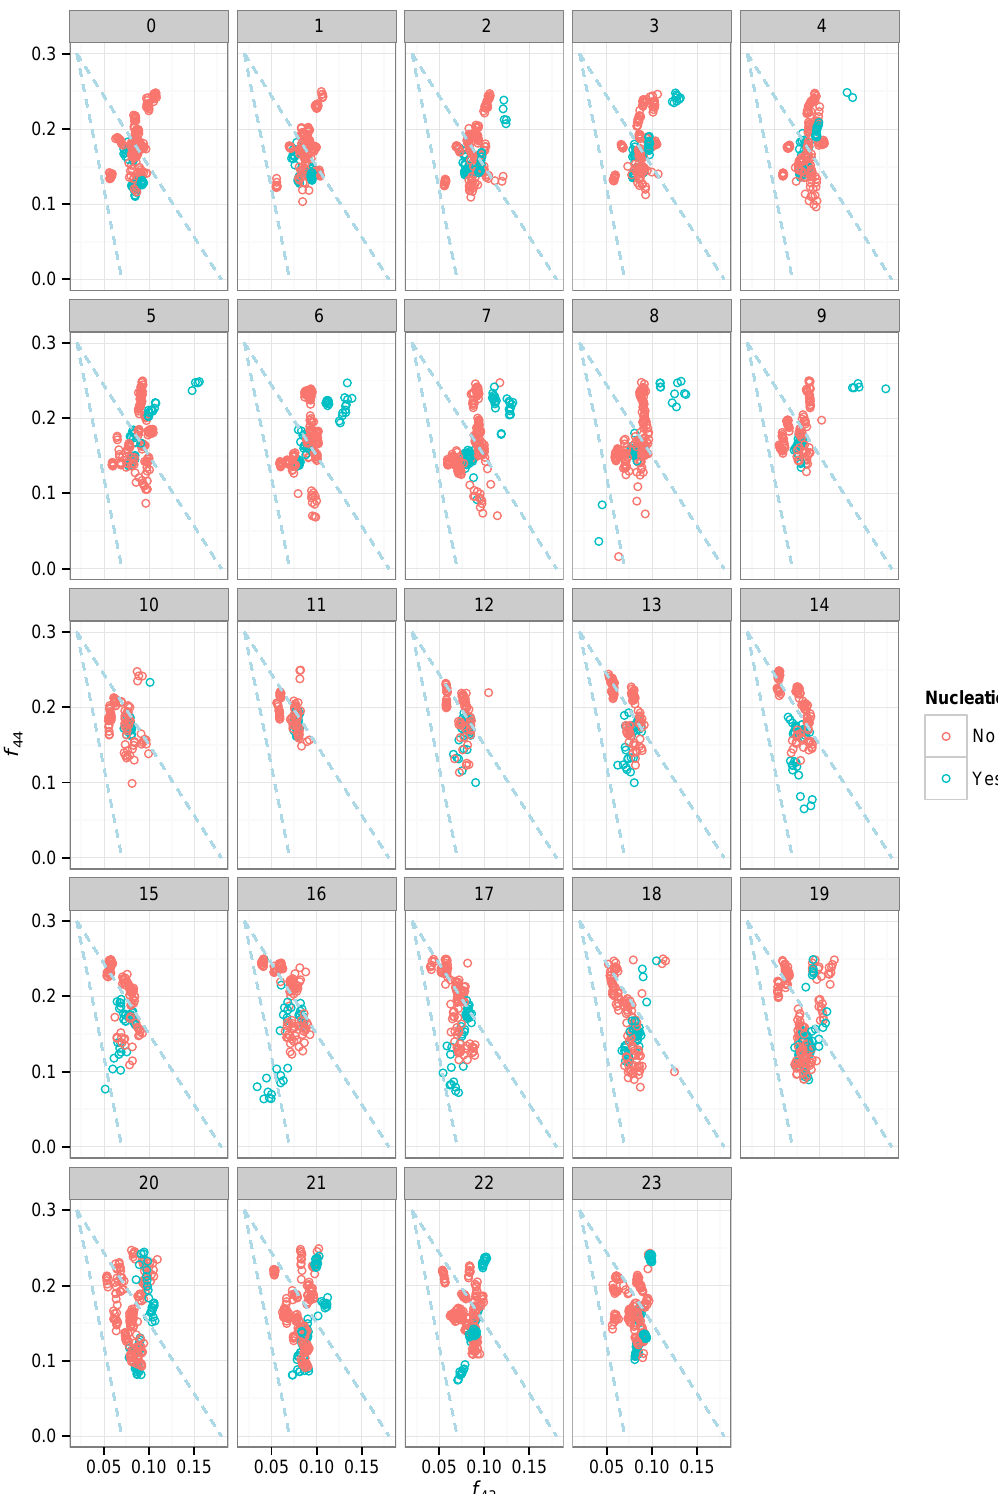
Figure 5. f 44 vs. f 43 at each hour of the day for all data measured during nucleation and non-nucleation days. The triangle from Ng et al. (2010b) is drawn as a visual aid. Within the period of 15–17, the newly formed particles grew enough to have significant contribution to total signal. Data include 5 and 51 nucleation and non-nucleation days